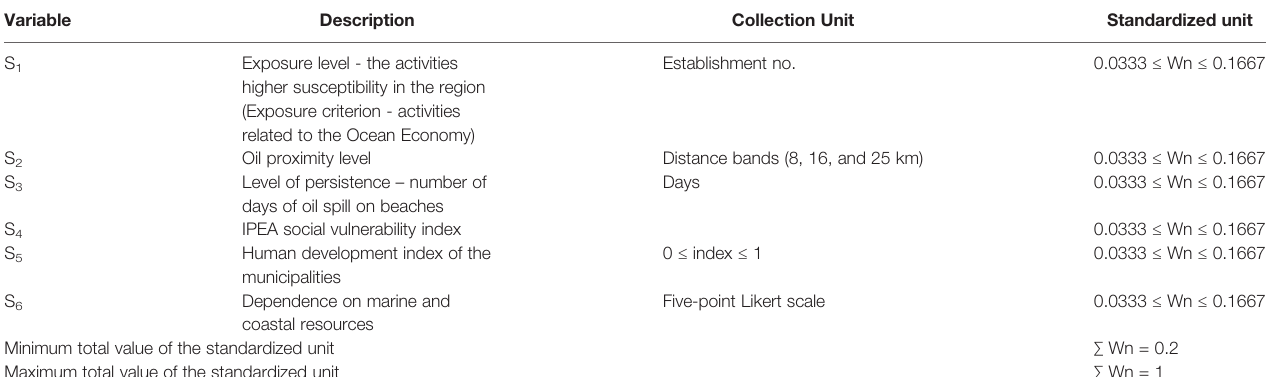
TABLE 2 | Description of the variables of the socioeconomic vulnerability indicator and respective units of analysis, which were based on Ca ̂ mara et al. (2020; 2021). Variable